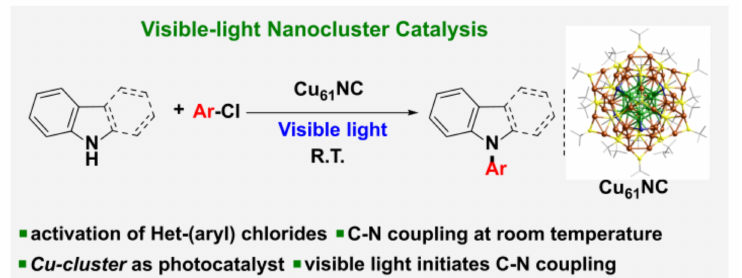
Figure 6. Visible-light copper nanocluster [Cu 61 (S t Bu) 26 S 6 Cl 6 H 14 ](Cu 61 NC) catalysis for the C − N coupling of aryl chlorides. Reprinted with permission from Ref. [31]. Copyright 2022, American Chemical